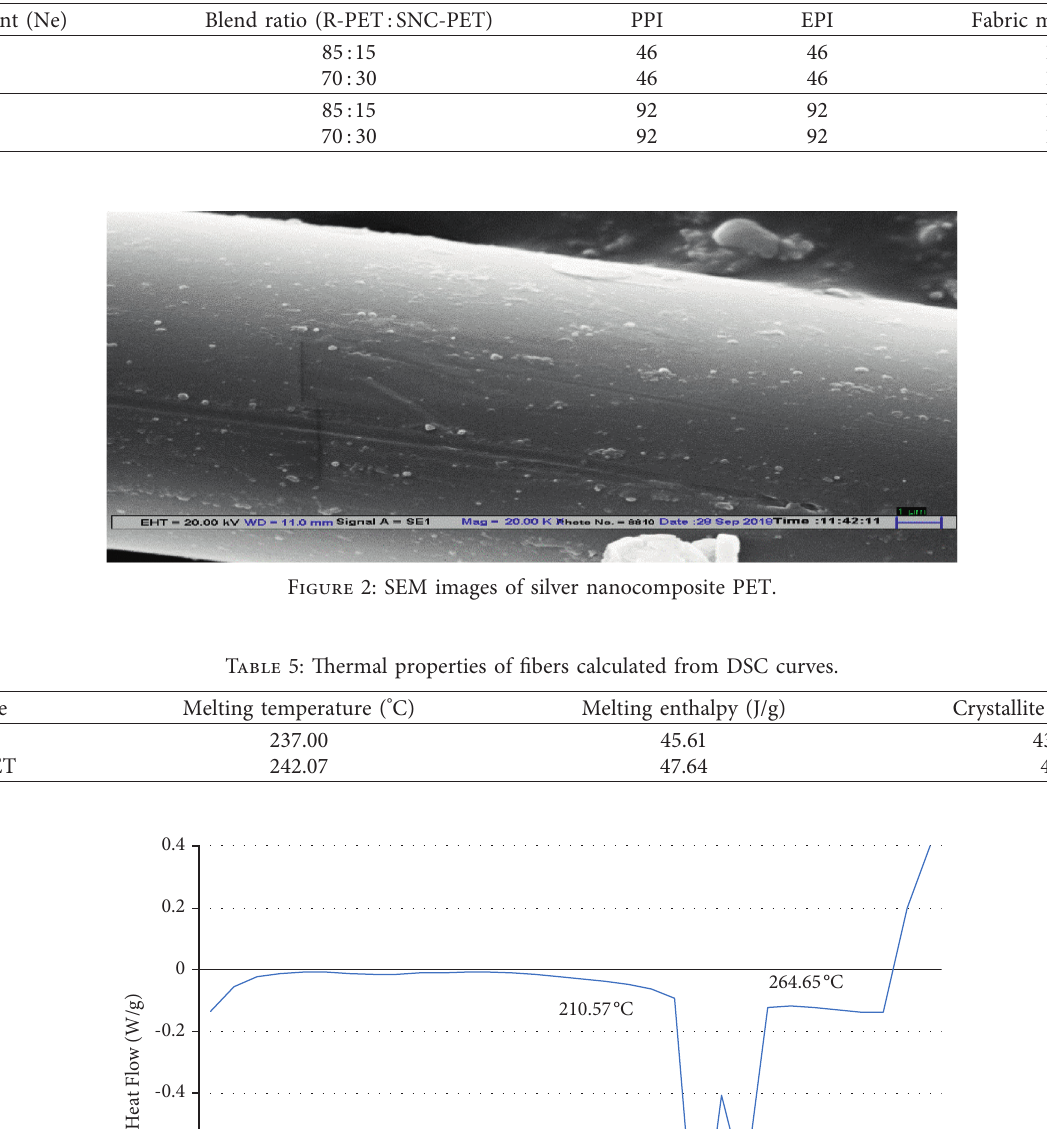
Table 4: Details of woven fabric parameters.